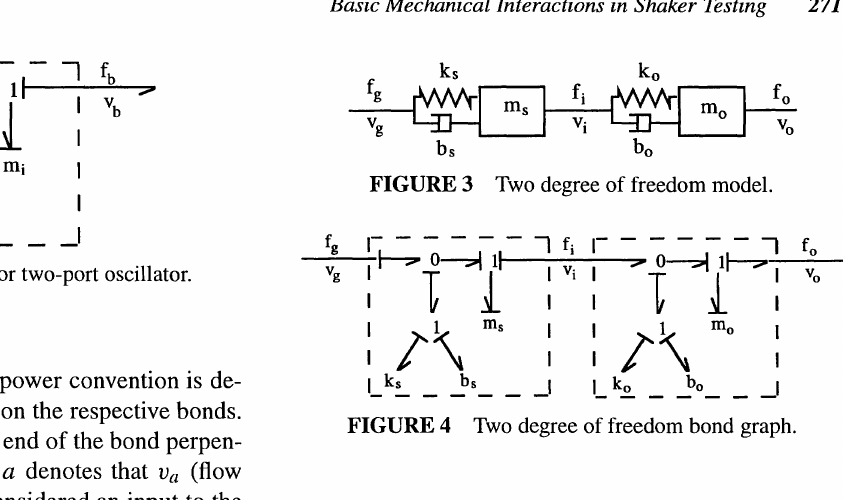
FIGURE 4 Two degree of freedom bond